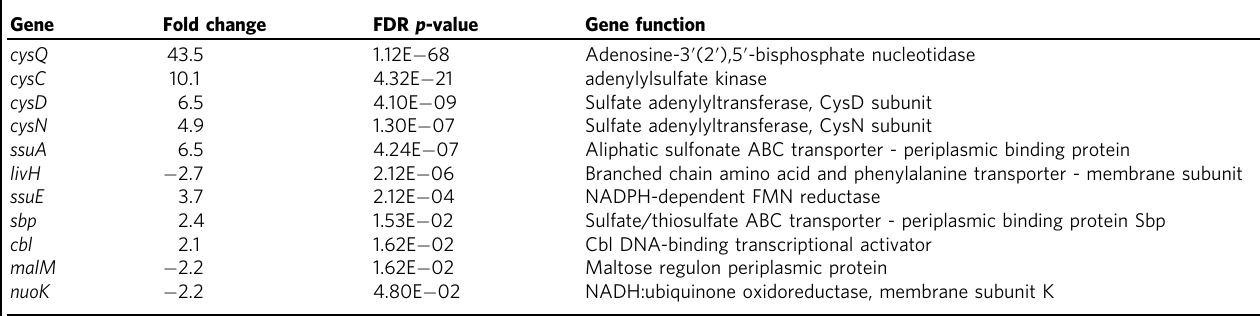
− 2.2 4.80E − 02 NADH:ubiquinone oxidoreductase, membrane subunit K Pairwise comparison of zosteric acid producing strain relative to control. Genes with false-discovery rate (FDR)-corrected p -values ( t -test) smaller than